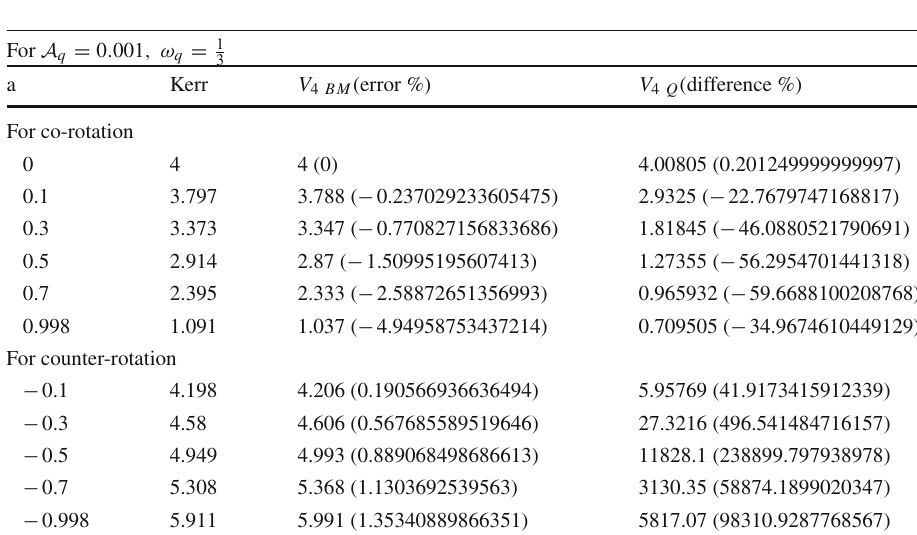
For A q = 0 . 001 , ω q = 1